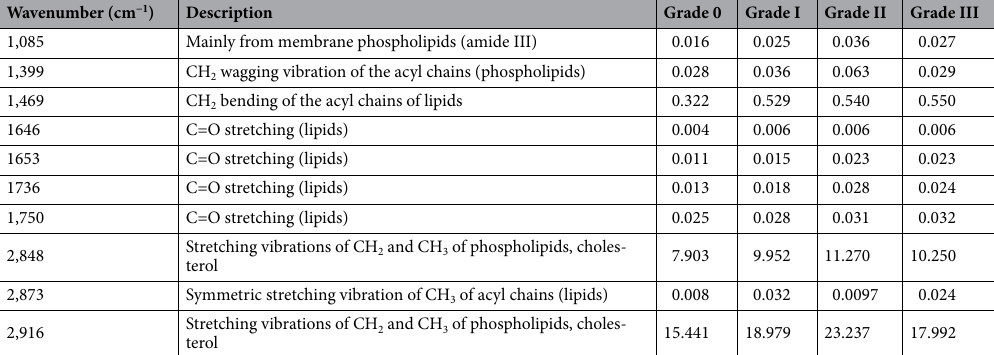
Table 2. Integrated FTIR spectra. The integrated spectra peak area depicts the concentration of chemical bonds of lipids for Grade 0, Grade I, Grade II and Grade III tissue